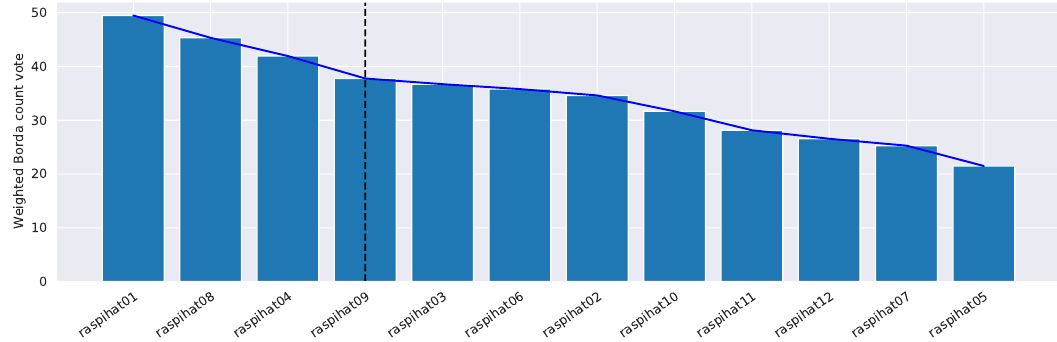
Figure 10. Weighted Borda count vote for each sensor. The vertical line represents the elbow of the graph, and it separates the selected sensors from the discarded